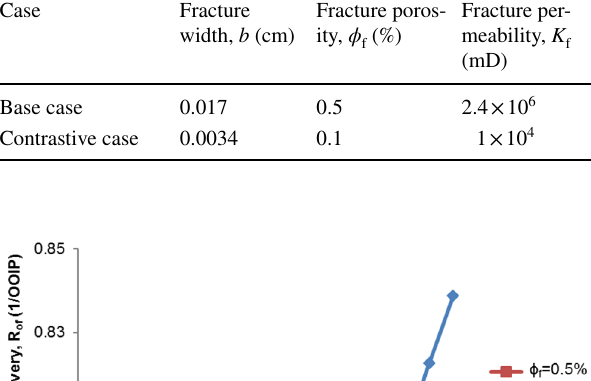
Table 9 Fracture properties in the base case and contrastive case Case